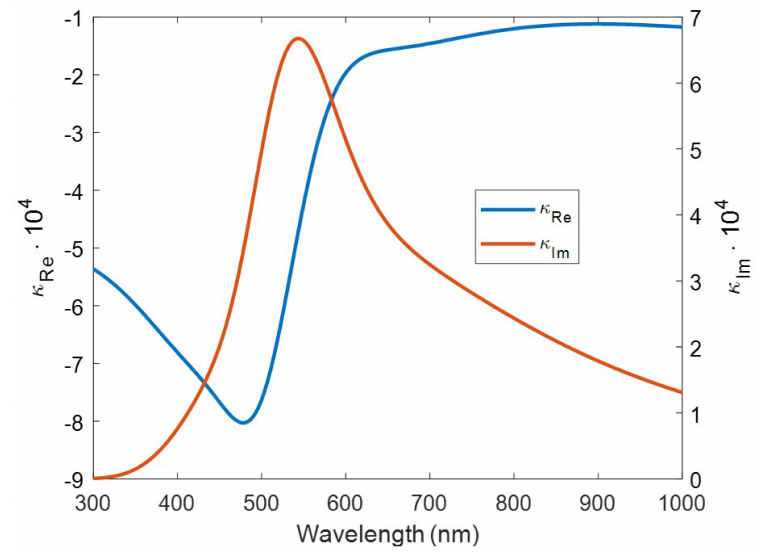
Figure 15. Model function with two Gaussian resonances for the chirality parameter κ of the CNC